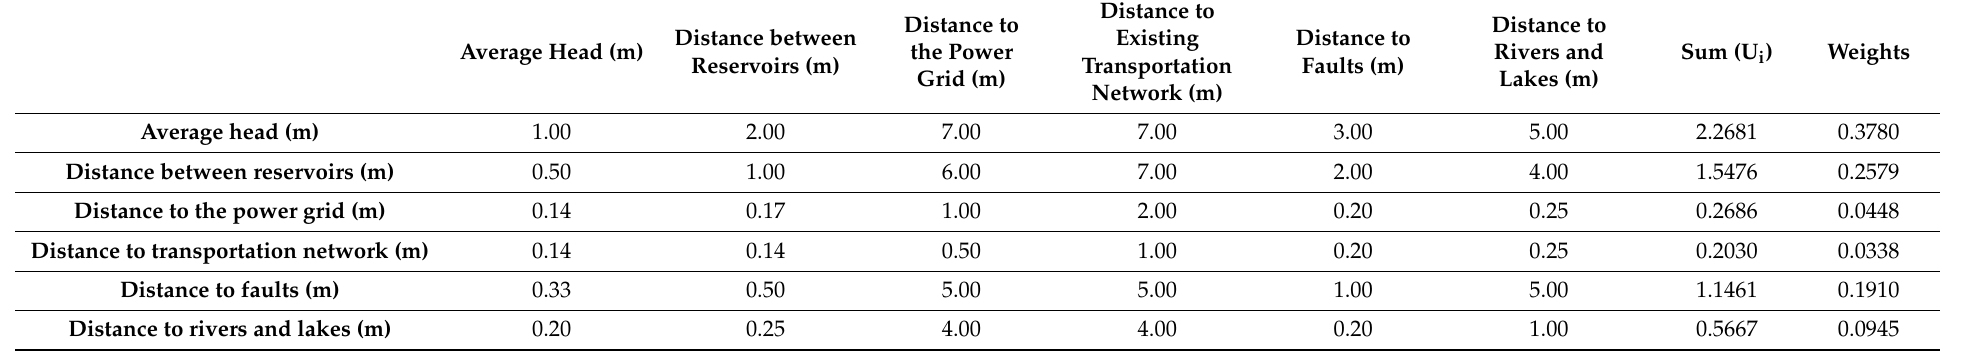
Table 5. Weights of the selected criteria for the AHP